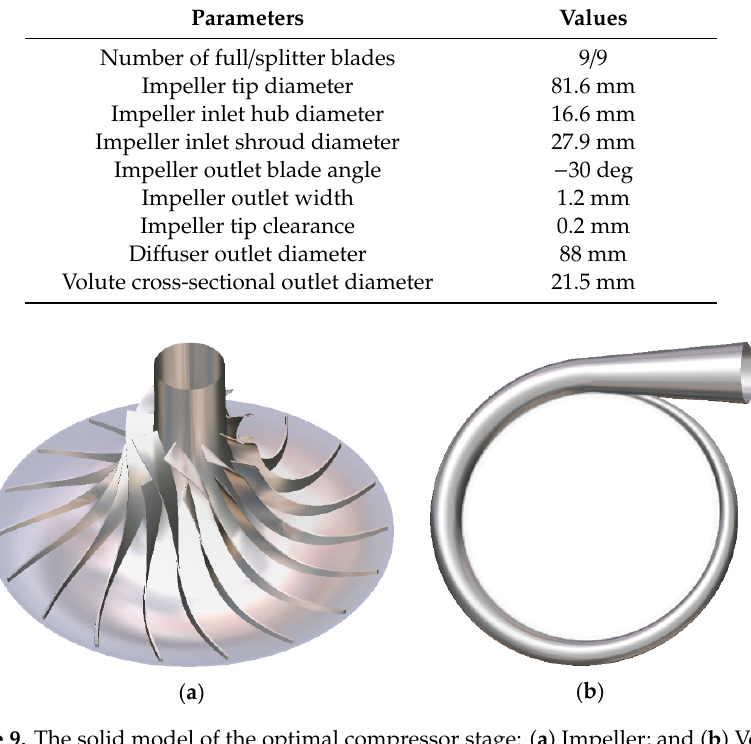
Table 6. Geometrical parameters of the optimal SCO 2 compressor stage.